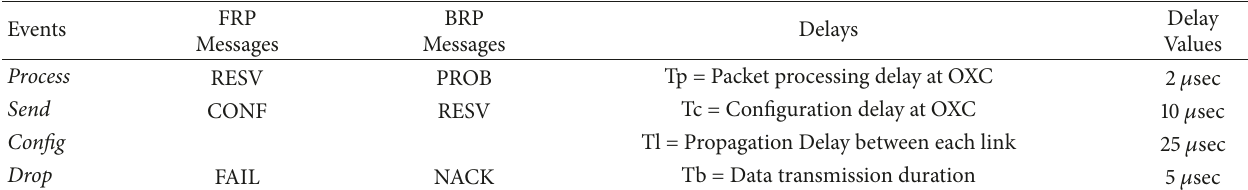
Table 1: Simulation events, control packets, delays, and delay values.